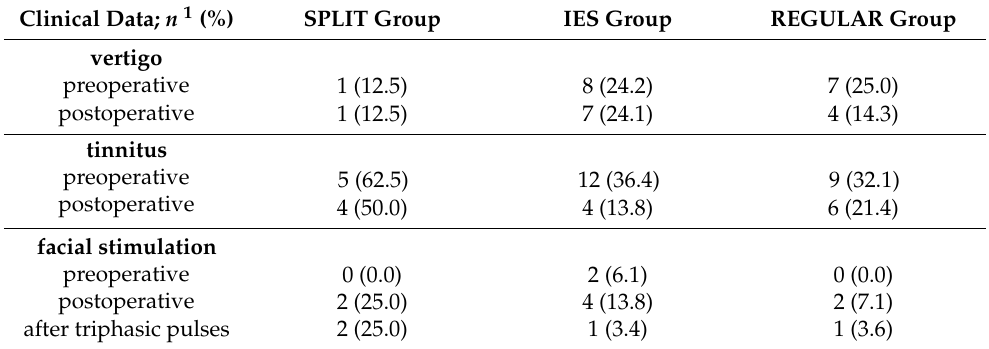
Table 2. Clinical